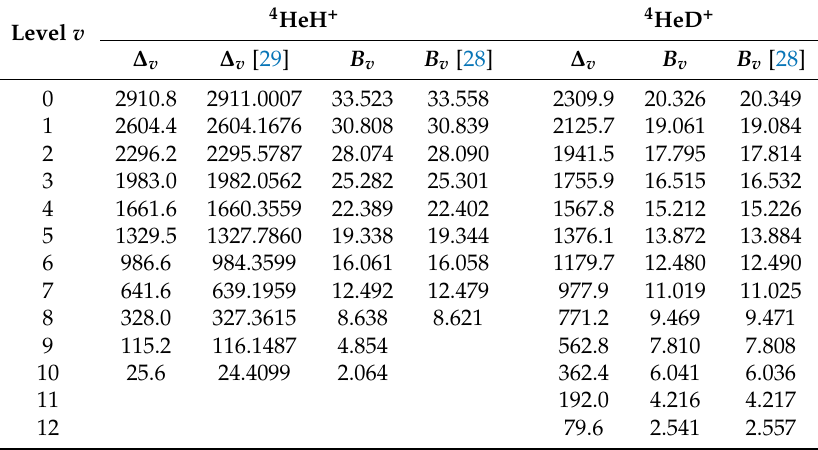
Table 1. Energies ∆ v = E v + 1 − E v for vibrational transitions v → v + 1 and rotational constants B v of the 4 HeH + and 4 HeD + molecules used in this study and compared with data available in the literature. All values are in cm − 1